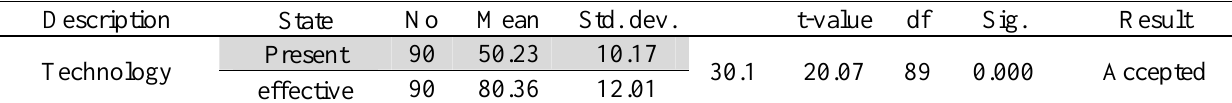
Evaluate significant difference between present and effective situation of technology subsystems Description